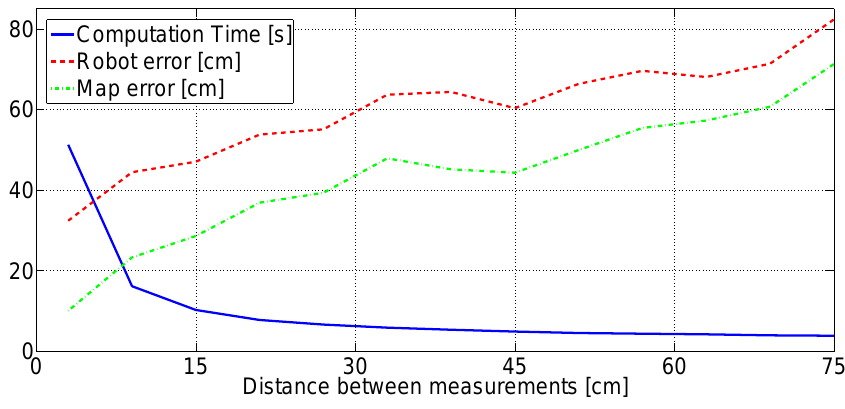
Figure 9. SLAM mean map error, robot error and computation times when using different measurement gathering